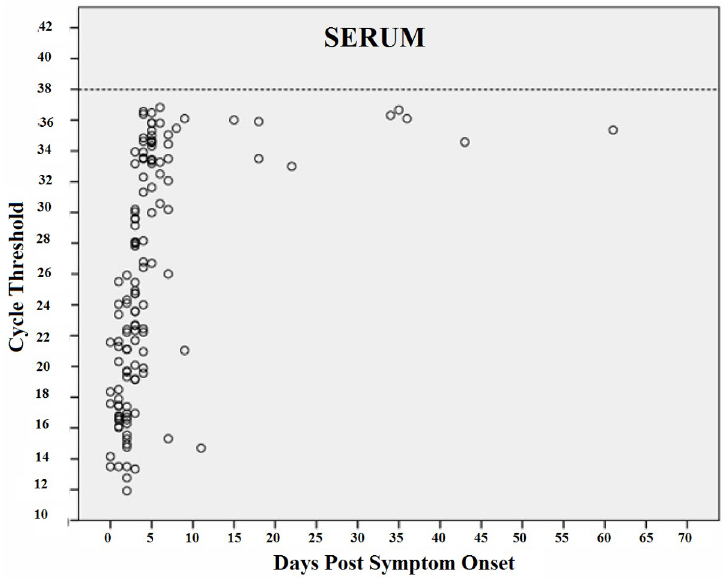
Fig 6. CHIKV Cycle Threshold (Ct) by days after the onset of symptoms in Serum.